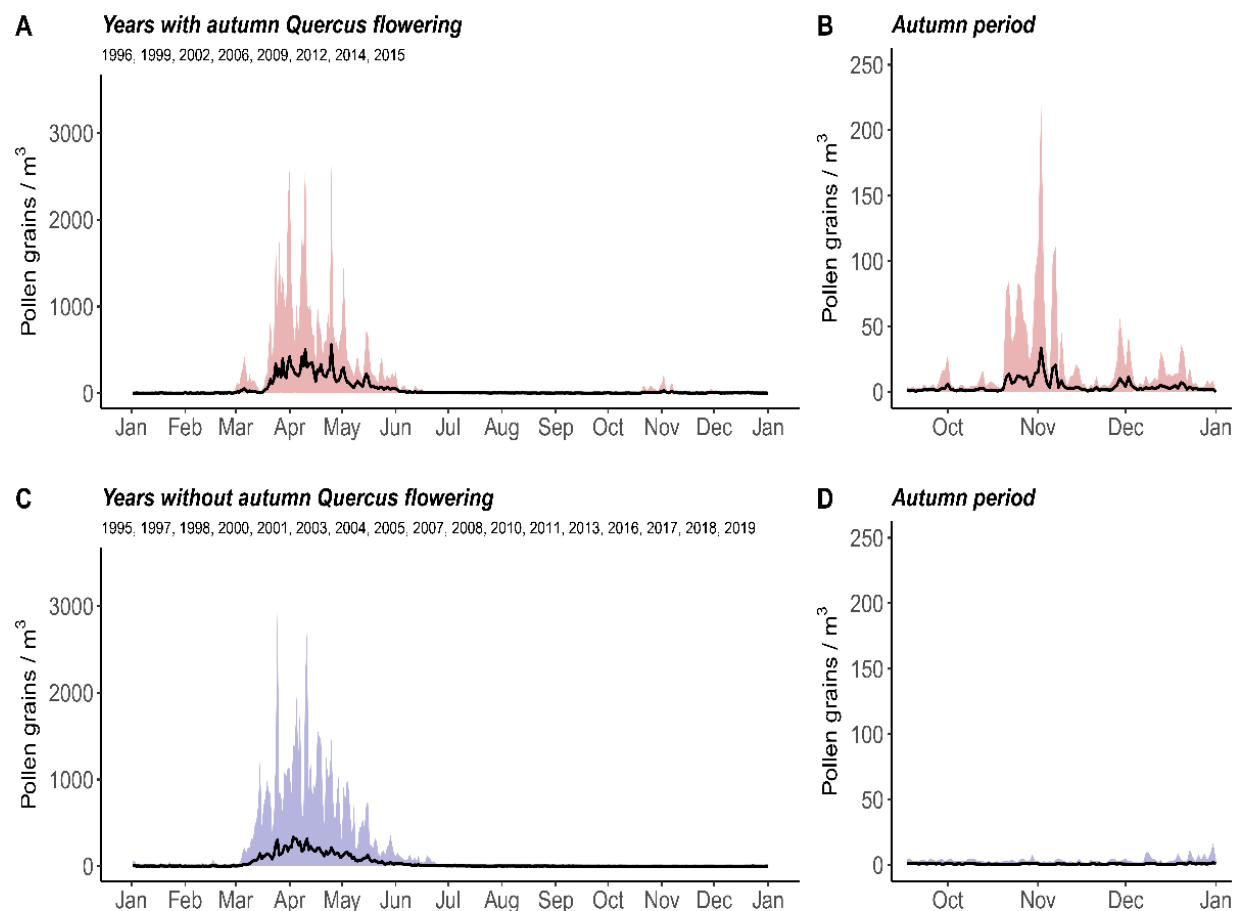
Figure 2. Distribution of daily average Quercus pollen concentrations in the atmosphere of C ó rdoba. Black lines represent the average daily pollen concentrations (i.e., average daily pollen concentration on that day of the year during the study period). Shaded areas represent the daily absolute ranges of pollen concentrations (i.e., from absolute minimum “minimum concentration recorded on that day of the year” to absolute maximum “maximum concentration recorded on that day of the year”). Plots A and B refer to the years in which autumn flowering was observed (i.e., autumn pollen integral > 100 pollen grains * day/m 3 in C ó rdoba). Plots C and D refer to the years in which autumn flowering was not observed.